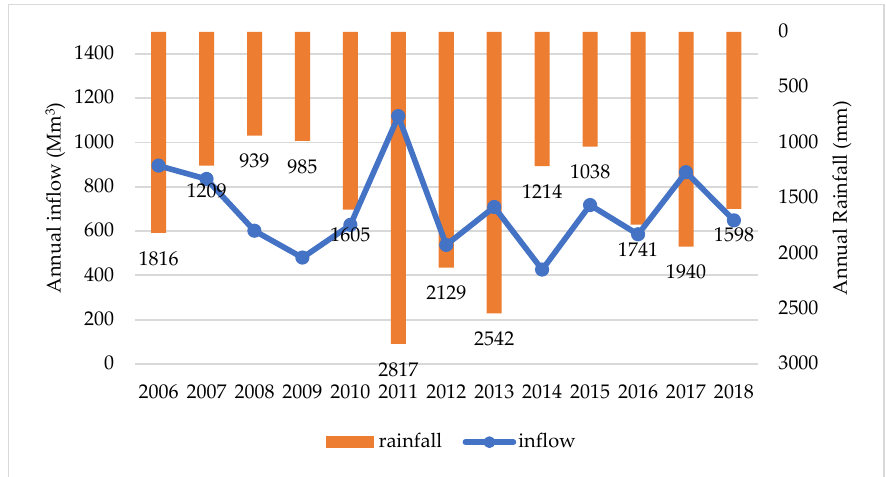
Figure A1. Average annual rainfall and annual inflow of the study site (recorded by the IWUMD).